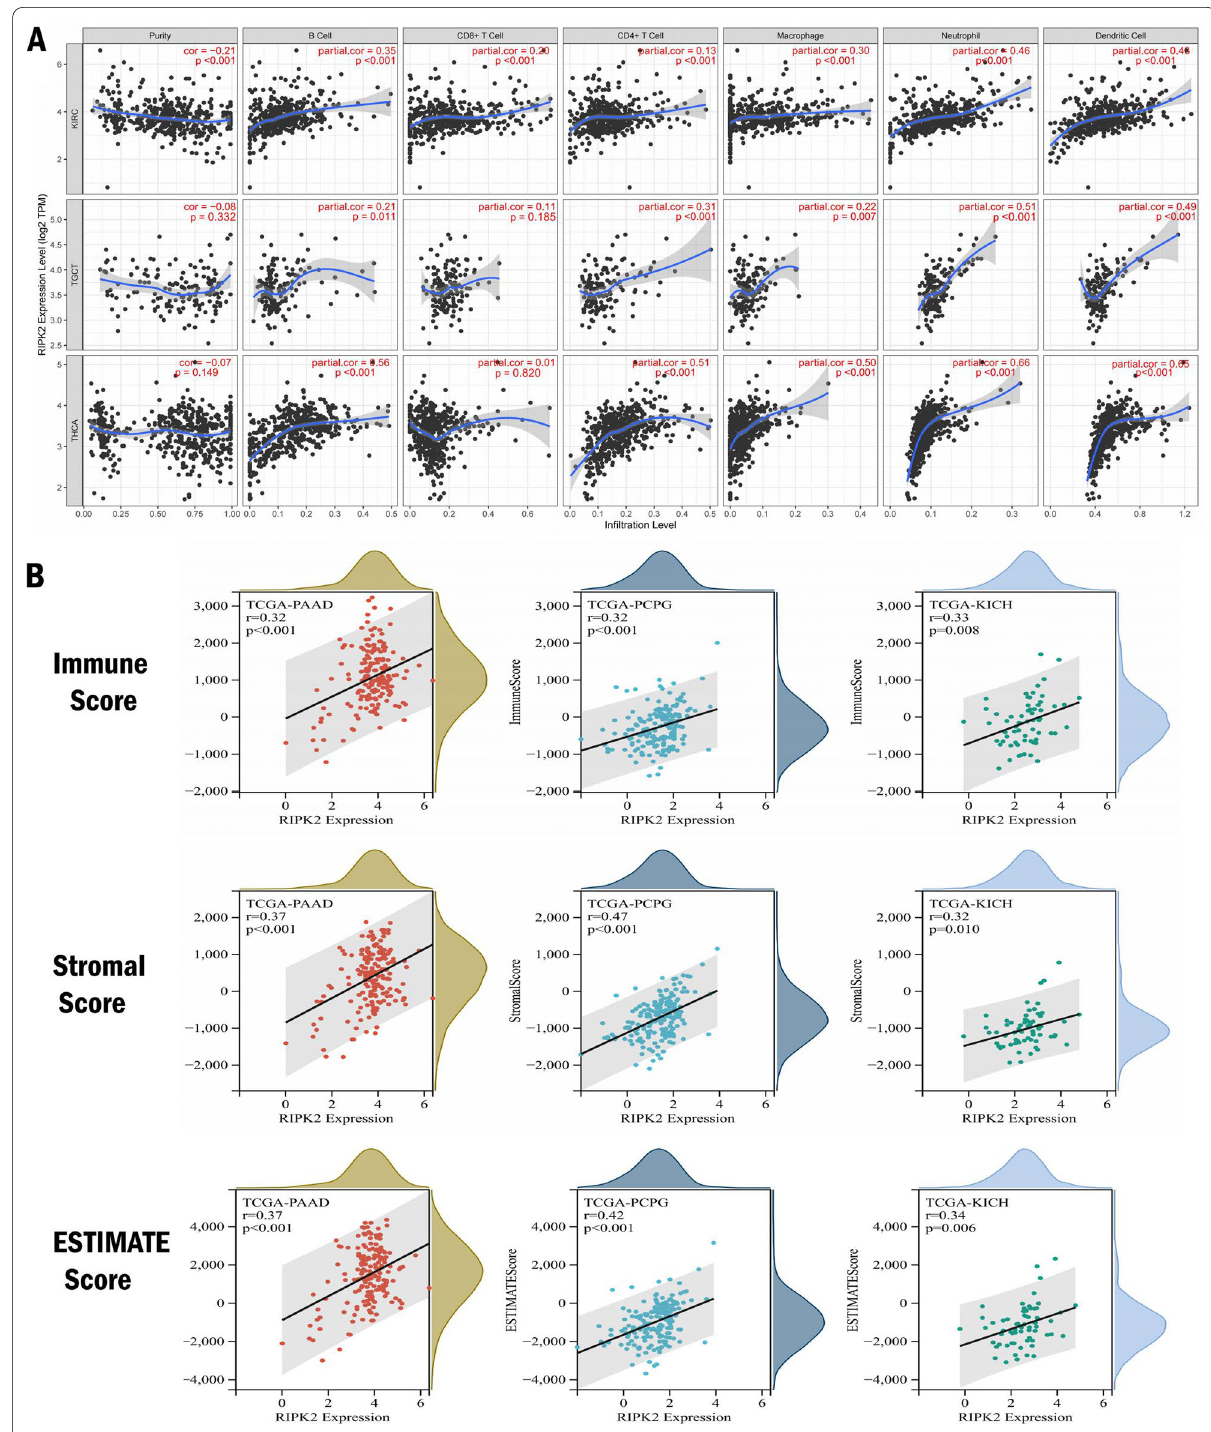
Fig. 4 Correlation between the expression of RIPK2 and the level of immune cell infiltration in various types of cancers. A Correlation of RIPK2 expression with immune infiltration status in KIRC, TGCT, THCA. B Correlation of RIPK2 expression with immune score, stromal score and ESTIMATE score in PAAD, PCPG and